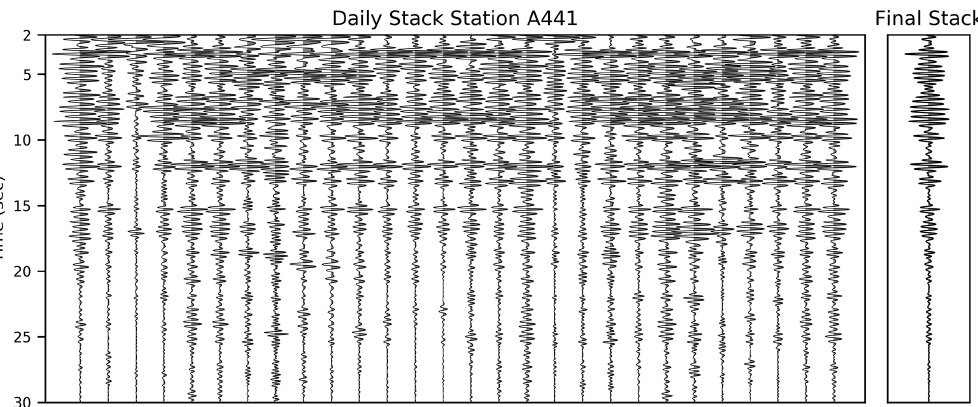
Figure 3. Daily autocorrelation section for station A441 showing the consistency of the retrieved reflections. On the right, the final stack is shown to compare the signal. Autocorrelations were computed using phase cross correlation within a frequency band between 1.5 to